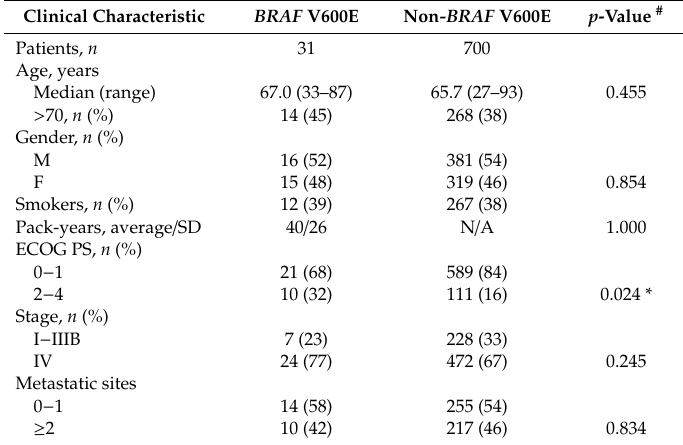
Table 1. Clinical characteristics of patients with lung adenocarcinoma with BRAF V600E mutation ( n = 31) or non- BRAF V600E mutations ( n = 700).